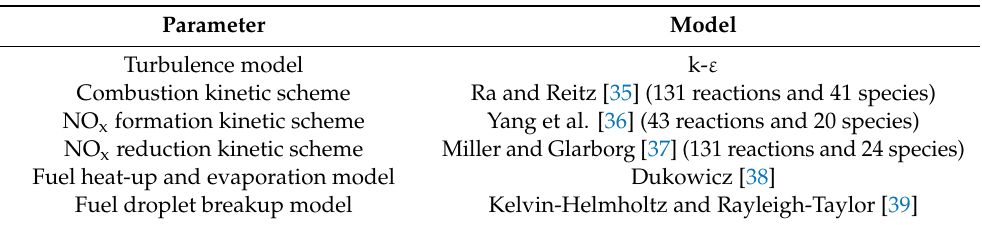
Table 2. Numerical details.